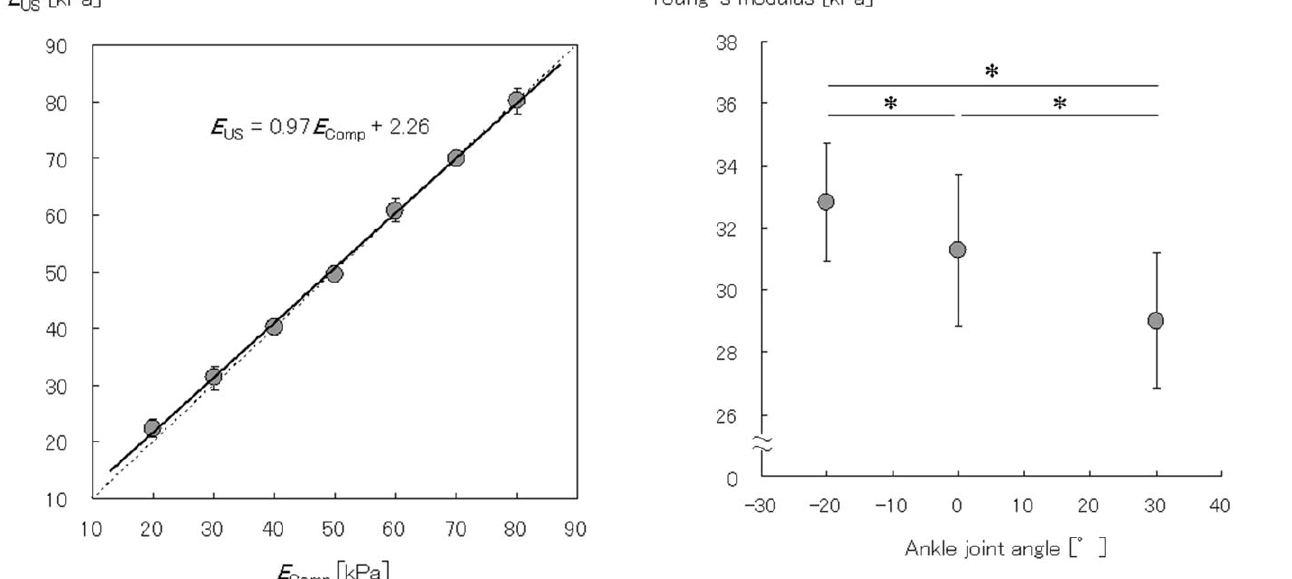
Figure 3. Comparison of the Young’s moduli of seven types of tissue-mimicking materials obtained using the mechanical displacement–load compression method ( E Comp ) and ultra- sound elastography ( E US ). The two independent methods of calculating Young’s modulus were significantly correlated (r=0.996, P , 0.001).